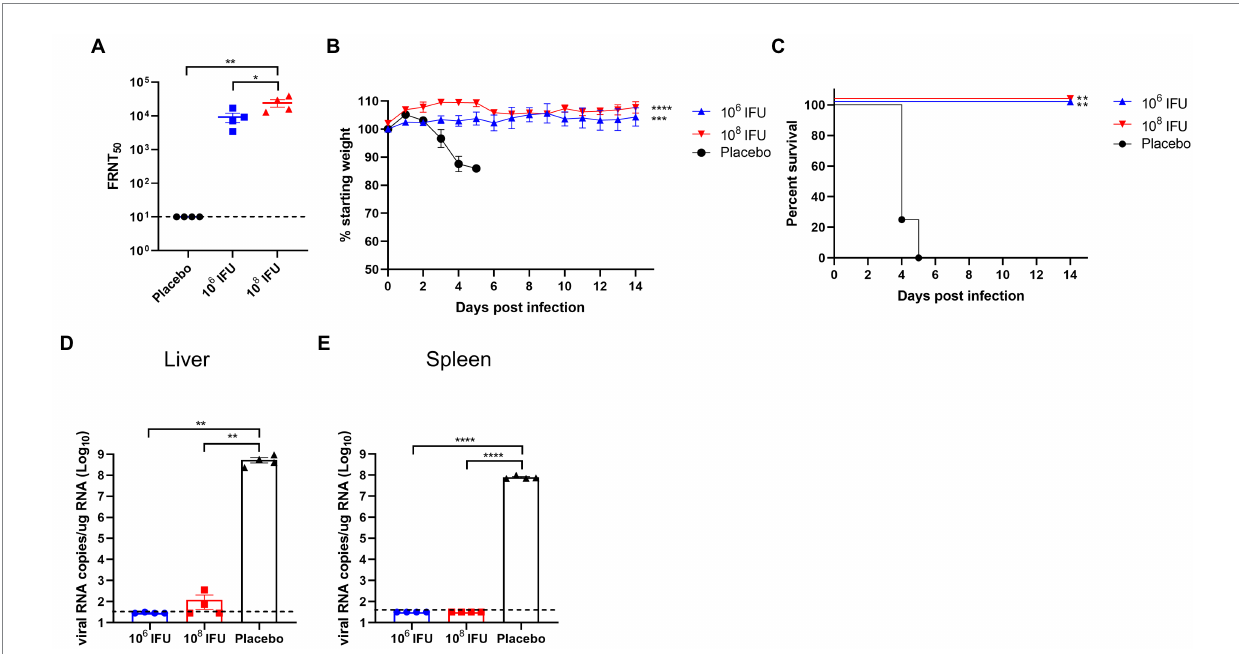
FIGURE 5 Protection efficacy of Ad5-GnGcopt against RVFV challenge in IFN receptor-deficient mice. A129 mice ( n = 4) were injected with one dose of 10 6 and 10 8 IFU of Ad5-GnGcopt or placebo via the intramuscular route. Four weeks after vaccination, mice were challenged intraperitoneally with 2 × 10 4 TCID 50 of the RVFV rMP-12 strain. (A) Sera collected at 4 weeks after vaccine immunization (before virus challenge) were examined for neutralizing antibodies using infectious RVFV. (B) Body weight change in mice after RVFV challenge. (C) The mortality and survival curves of mice. (D,E) Viral loads in livers (D) and spleens (E) of challenged mice were determined by qRT-PCR at the time of death (placebo group) or 14 days after the challenge (vaccine immunized groups). Data are displayed as means ± SEM. Comparisons for FRNT 50 and viral RNA copies based on two-way ANOVA with Sidark’s multiple comparisons test with * p < 0.05, ** p < 0.01, *** p < 0.001, and **** p < 0.0001. The weight curves were analyzed using one-way ANOVA (Multiple comparisons) test with * p < 0.05, ** p < 0.01, *** p < 0.001, and **** p < 0.0001. The Kaplan–Meier survival curves were analyzed using the Log-rank (Mantel-